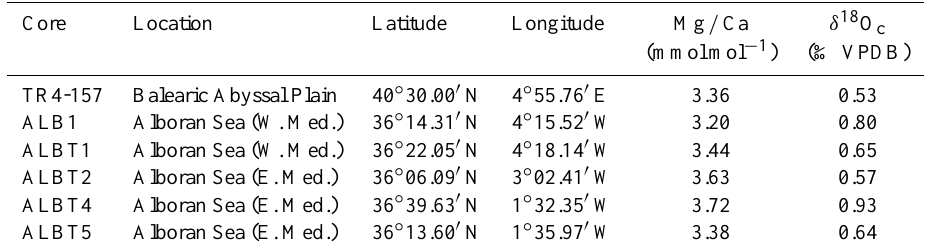
Table 1. Core tops included in the calibration’s adjustment. δ 18 O c and Mg / Ca have been obtained from G. bulloides (Mg / Ca procedure has been performed without reductive